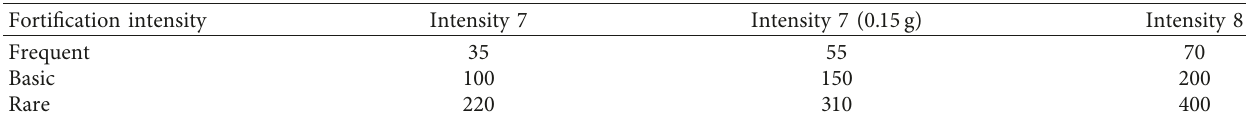
Figure 4: Time-history curve and response spectrum of the input ground motion. (a) Artificial wave, (b) El Centro, and (c) Hollywood. Table 9: Peak accelerations of different level of intensity (cm/s 2